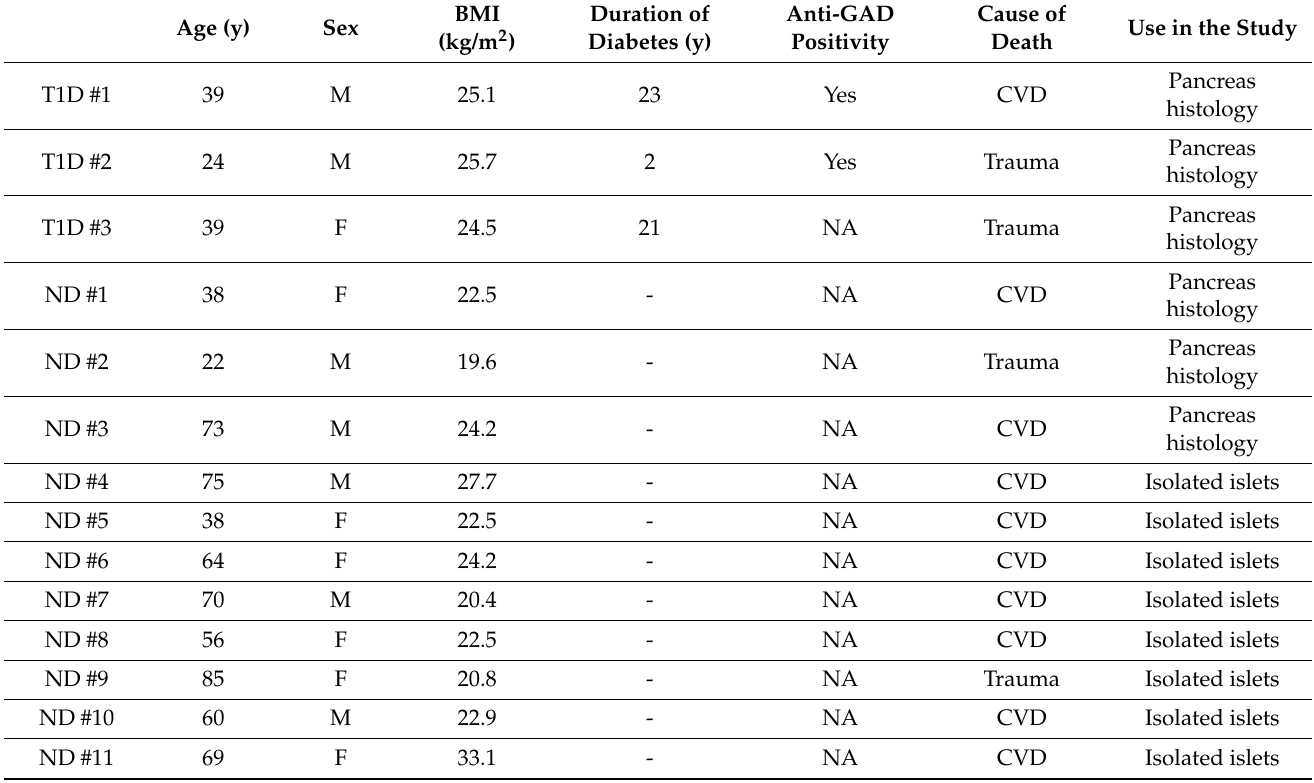
Table 1. Clinical characteristics of the